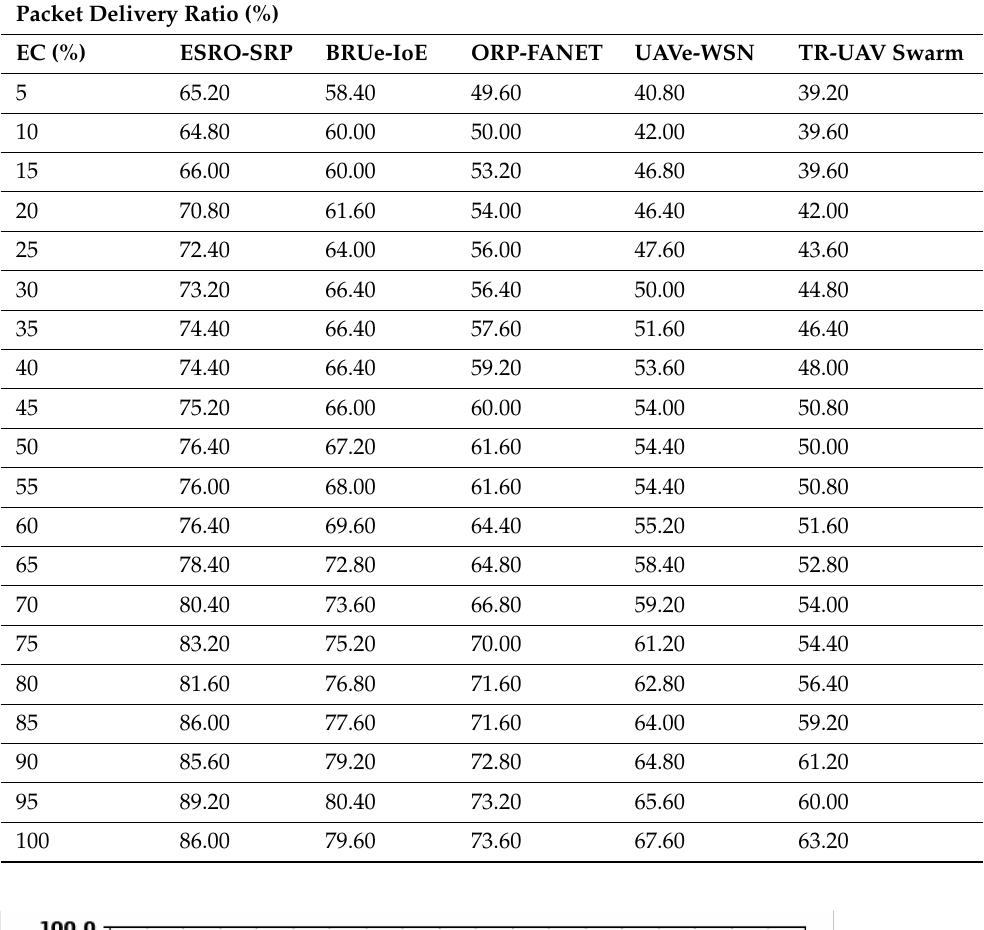
Table 2. PDR analysis of ESRO-SRP technique with existing algorithms under distinct levels of energy.